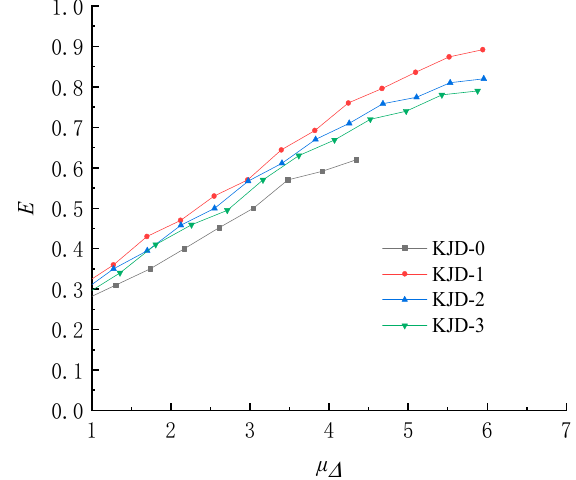
Figure 15. Cumulative energy dissipation curves.